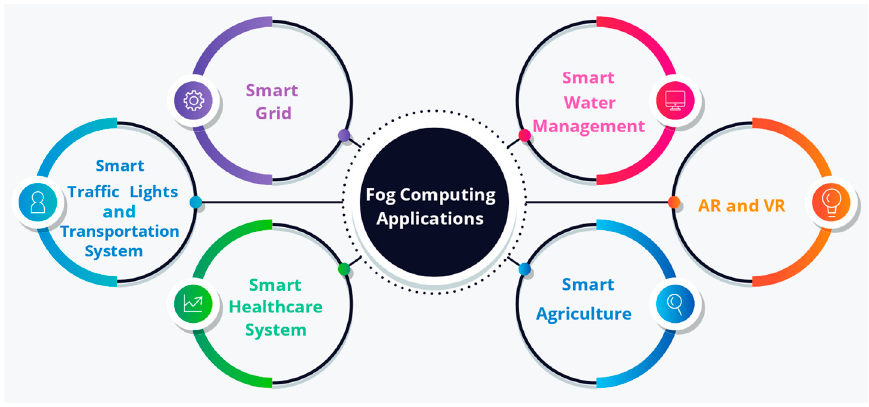
Figure 11. Applications of fog computing.